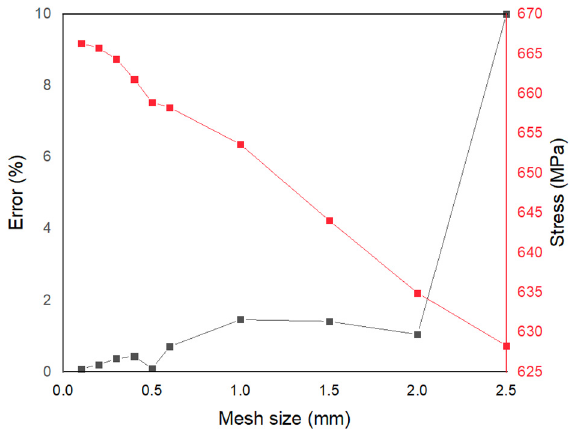
Figure 10. Stress values (red) at 4% strain and respective error % (black) for different mesh sizes.